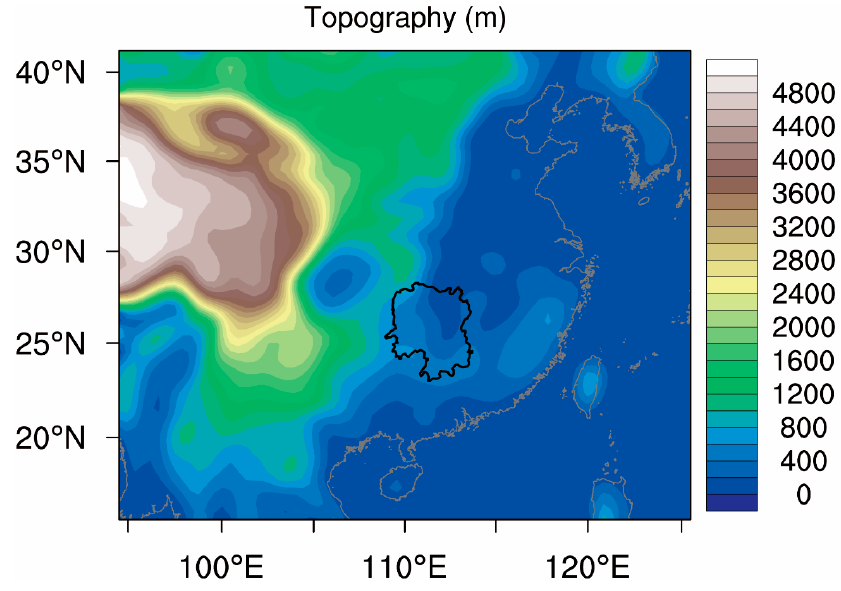
Figure 1. The location and topography of Hunan Province in China. Table 2. Magnitude distribution of hourly precipitation (Unit: